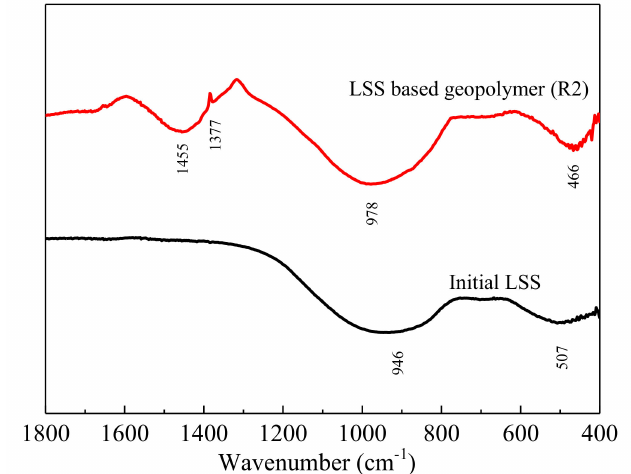
Figure 6. FTIR patterns of the initial LSS and LSS based geopolymer (R 2 ) after being hydrated for 28